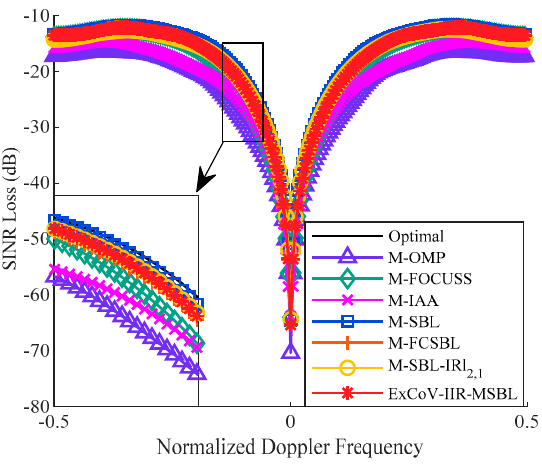
Figure 8. SINR loss comparison of different algorithms with gain-phase error.